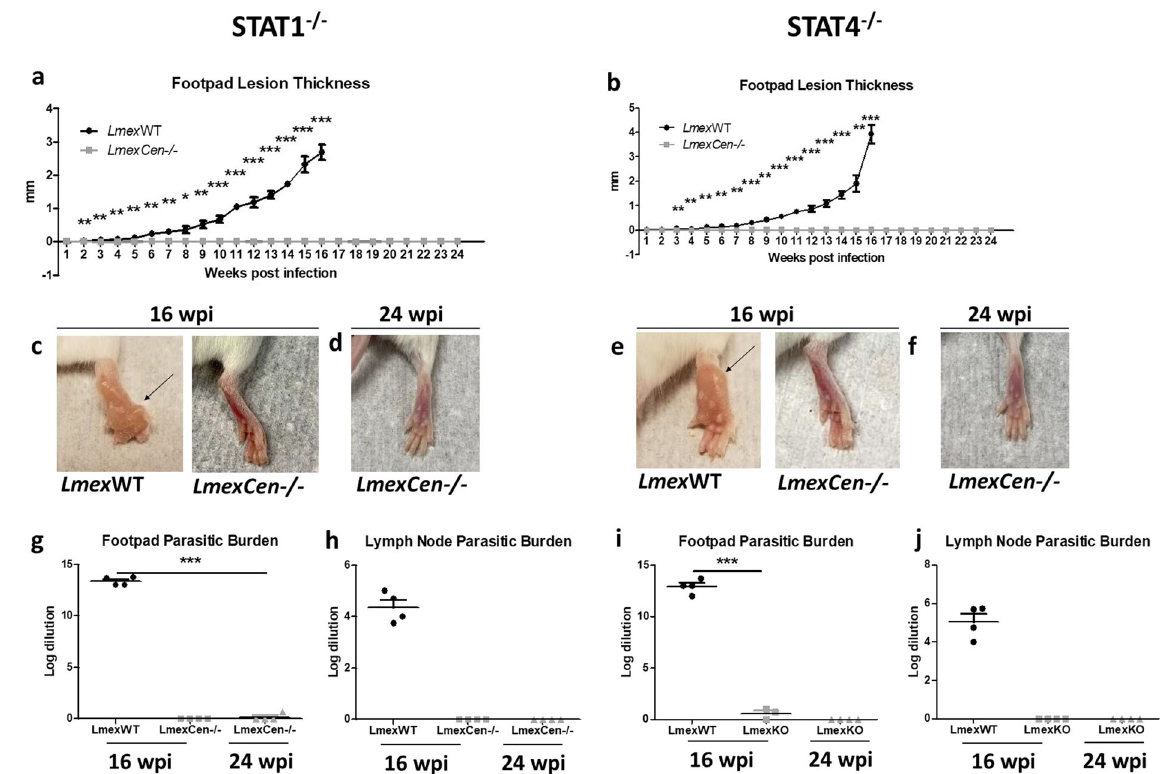
Fig. 3 LmexCen − / − parasites do not lead to lesion development in immunocompromised mice. For this experiment, STAT1 − / − and STAT4 − / − female mice were inoculated in the footpad with 10 × 10 6 Lmex WT or LmexCen − / − promastigotes in the stationary phase. a , b Lesion thickness in footpad of STAT1 − / − ( a ) and STAT4 − / − ( b ) mice. c , e Representative footpad of STAT1 − / − ( c ) and STAT4 − / − ( e ) mice inoculated with Lmex WT promastigotes at 16 weeks post infection (wpi). d , f Representative footpad of STAT1 − / − ( d ) and STAT4 − / − ( f ) mice inoculated with LmexCen − / − promastigotes at 24 wpi. g , i Footpad parasitic burden of STAT1 − / − ( g ) and STAT4 − / − ( i ) mice. h , j Lymph node parasitic burden of STAT1 − / − ( h ) and STAT4 − / − ( j ) mice. Data show one representative experiment out of two independent experiments and show mean ± SEM, N = 4 for each group at each time point. Unpaired two-tailed Student ’ s t -test was performed to compare statistical signi fi cance at each time point. A P -value < 0.05 was considered signi fi cant. In all panels * represents P ≤ 0.05, ** represents P ≤ 0.01, and *** represents P ≤